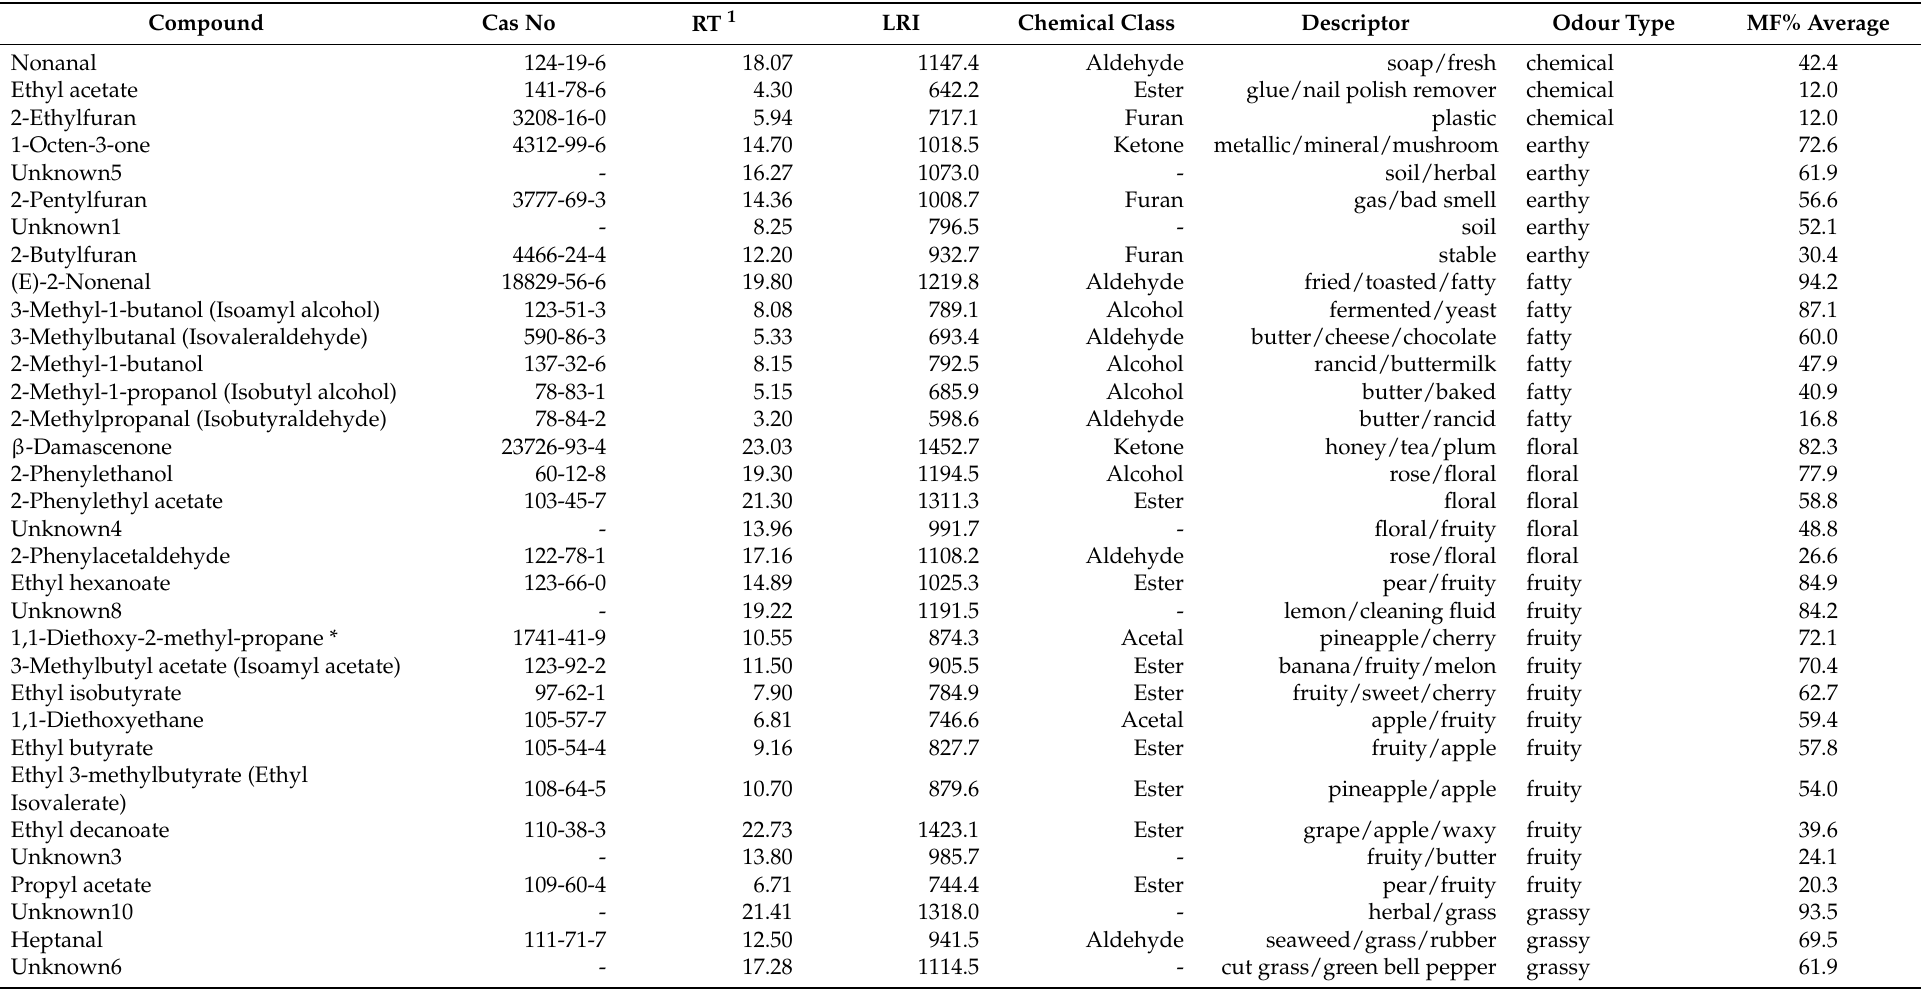
Table 1. Aroma active compounds and their modified frequency percentage (MF%) average values detected in new make spirit by gas chromatography oflactometry (GCO)/MS